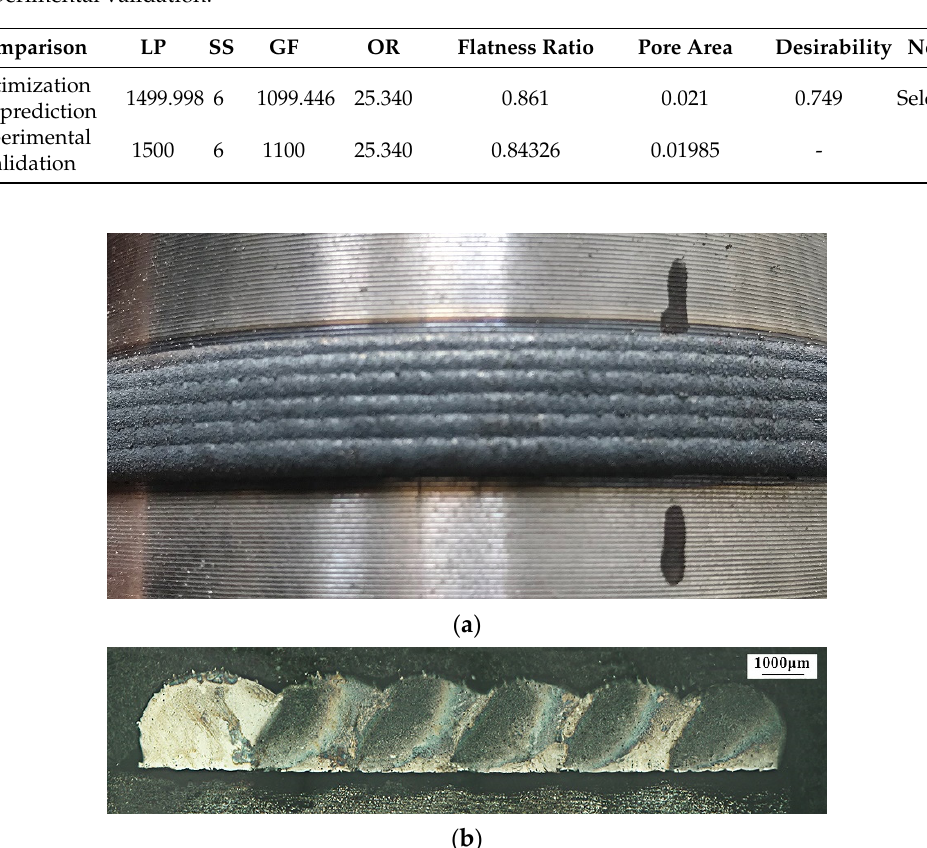
Figure 12. ( a ) Exterior appearance of laser clad coated on the substrate; ( b ) Cross-section of multi- track